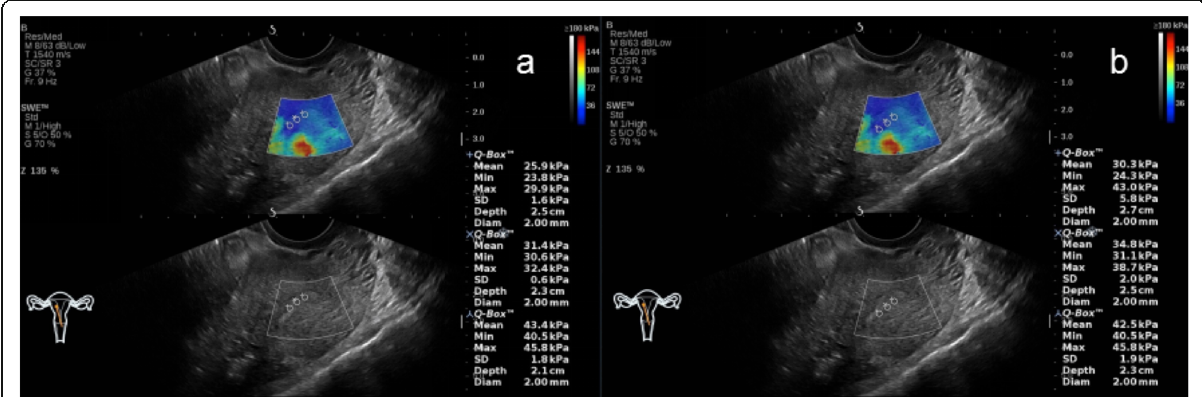
Fig. 6 Representative images of a woman in the ATTMAA group. a Young ’ s modulus at the three sites of the anterior endometrial wall was 25.9, 31.4, and 43.4 kPa, respectively; b Young ’ s modulus at the three sites of the posterior endometrial wall was 30.3, 34.8, and 42.5 kPa, respectively. The mean Young ’ s modulus of the six sampling sites was 34.7 kPa